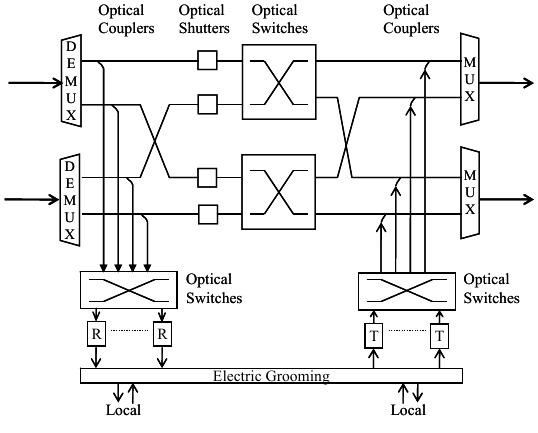
In addition to the node architecture, the authors of Ref. 19 proposed an auxiliary graph model for dynamic traffic grooming algorithm in TILT networks. Let W denote the number of wavelengths on each fiber and G = ( V 0 , E 0 ) stand for the given physical network topology, where V 0 is the set of nodes and E 0 is the set of edges. Then the model generates the following three auxiliary